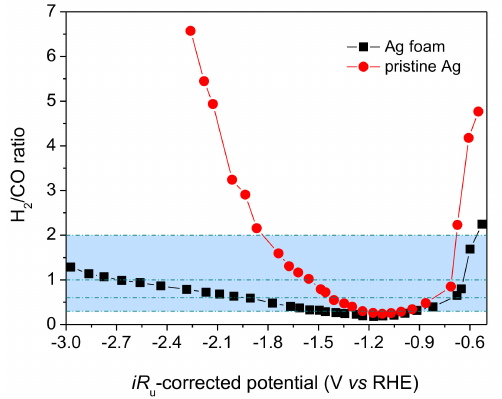
Figure 6. Ratio of H 2 :CO in Ag foam and pristine Ag electrodes as a function of electrode potential. Experimental conditions: anolyte, 0.5 M NaOH; catholyte, CO 2 -saturated 0.1 M KHCO 3 ; 25 ◦ C.